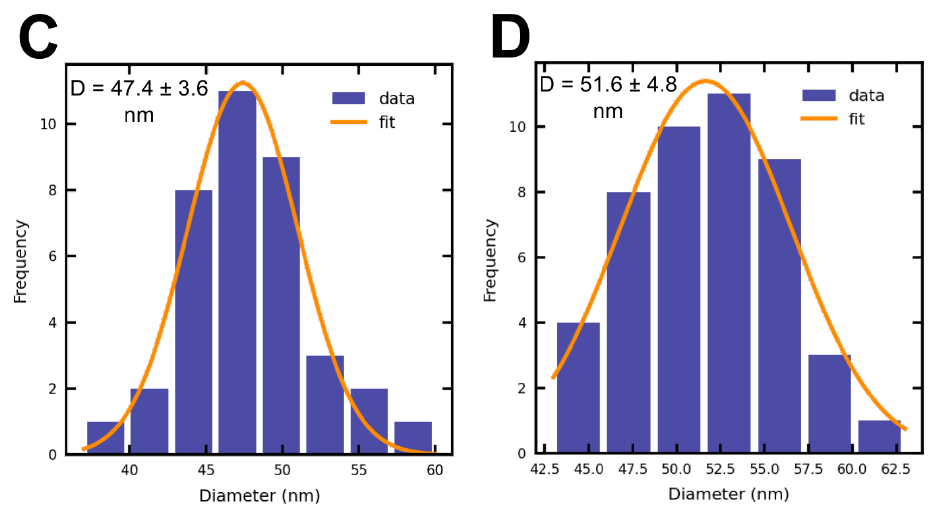
Figure A4. TEM images of the ( A ) gold and ( B ) silver nanoparticles. Size distribution measurements of these ( C ) gold and ( D ) silver nanoparticles.